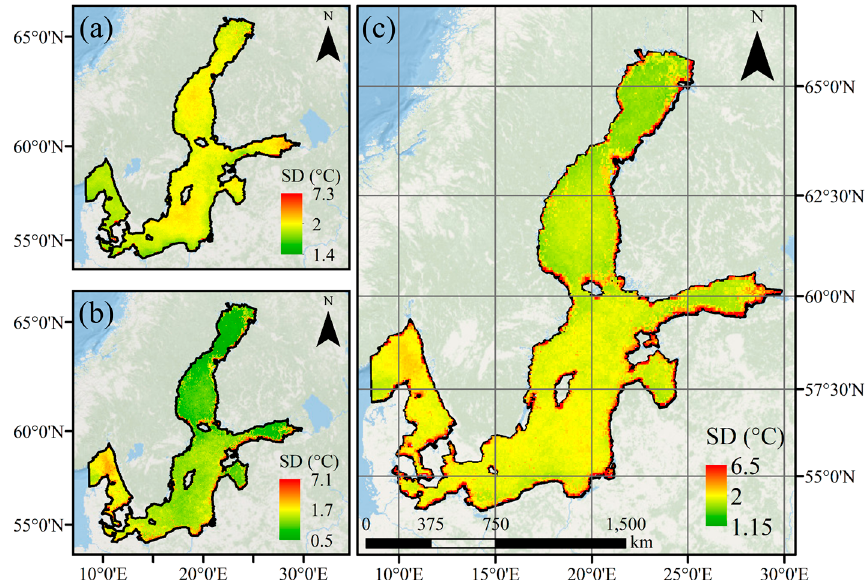
Figure 4. Standard deviation (SD) of AVHRR Pathfinder sea surface temperature (SST) of the Baltic Sea over the last four decades based on ( a ) annual maximum SST, ( b ) annual minimum SST, and their spatial average ( c ) acquired at night.